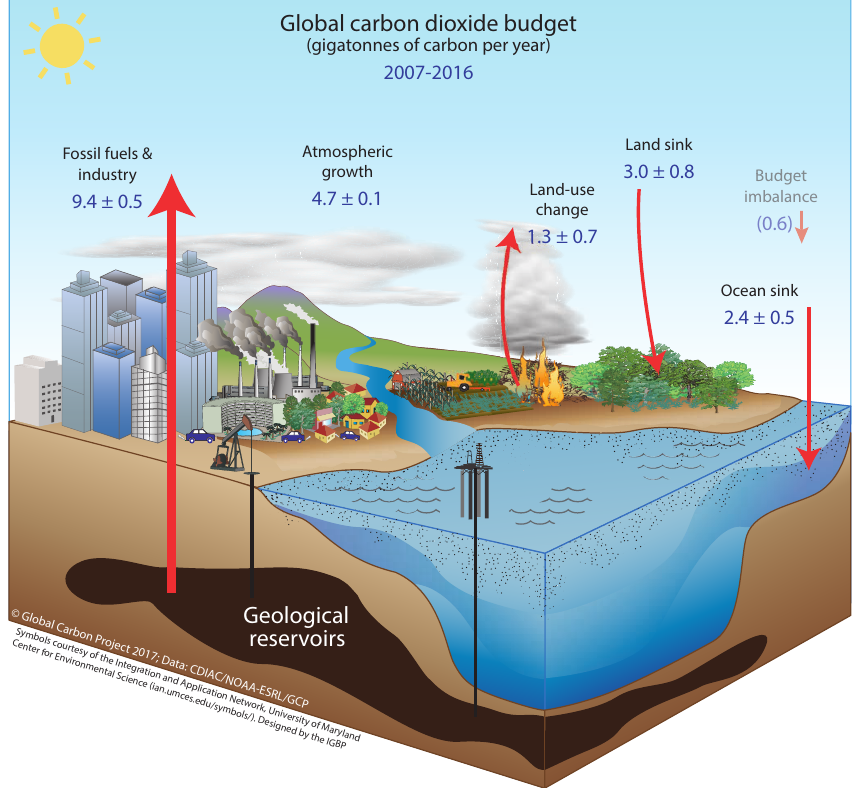
Figure 2. Schematic representation of the overall perturbation of the global carbon cycle caused by anthropogenic activities, averaged globally for the decade 2007–2016. The values represent emission from fossil fuels and industry ( E FF ), emissions from deforestation and other land-use change ( E LUC ), the growth rate in atmospheric CO 2 concentration ( G ATM ), and the uptake of carbon by the sinks in the ocean ( S OCEAN ) and land ( S LAND ) reservoirs. The budget imbalance ( B IM ) is also shown. All fluxes are in units of GtCyr − 1 , with uncertainties reported as ± 1 σ (68% confidence that the real value lies within the given interval) as described in the text. This figure is an update of one prepared by the International Geosphere-Biosphere Programme for the GCP, using diagrams created with symbols from the Integration and Application Network, University of Maryland Center for Environmental Science (http://ian.umces.edu/symbols/), first presented in Le Quéré (2009). Table 1. Factors used to convert carbon in various units (by convention, Unit 1 = Unit 2 conversion). Unit 1 Unit 2 Conversion Source GtC (gigatonnes of carbon) ppm (parts per million) a GtC (gigatonnes of carbon) PgC (petagrams of carbon) GtCO 2 (gigatonnes of carbon dioxide) GtC (gigatonnes of carbon) GtC (gigatonnes of carbon) MtC (megatonnes of carbon) 1000 SI unit conversion a Measurements of atmospheric CO 2 concentration have units of dry-air mole fraction. “ppm” is an abbreviation for micromole per mol of dry air. b The use of a factor of 2.12 assumes that all the atmosphere is well mixed within 1 year. In reality, only the troposphere is well mixed and the growth rate of CO 2 concentration in the less well-mixed stratosphere is not measured by sites from the NOAA network. Using a factor of 2.12 makes the approximation that the growth rate of CO 2 concentration in the stratosphere equals that of the troposphere on a yearly